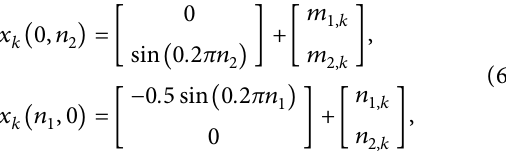
k k with iteration number